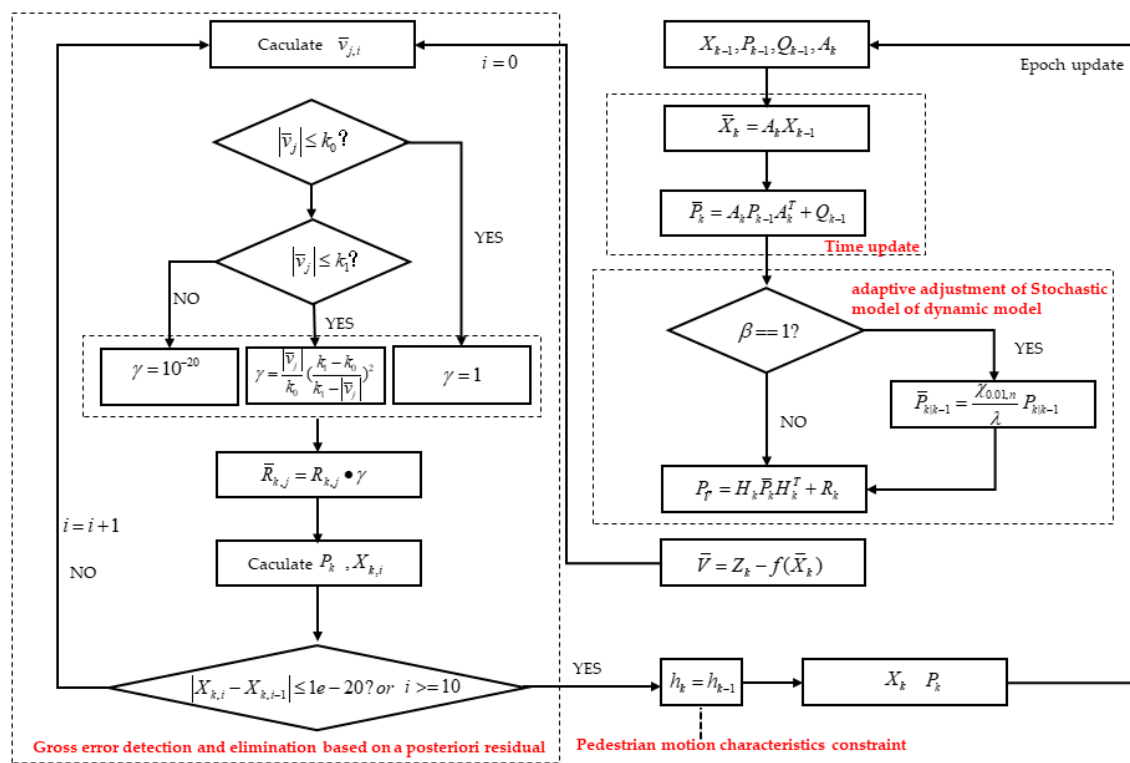
Figure 3. BDS/GPS/UWB tightly coupled positioning model.